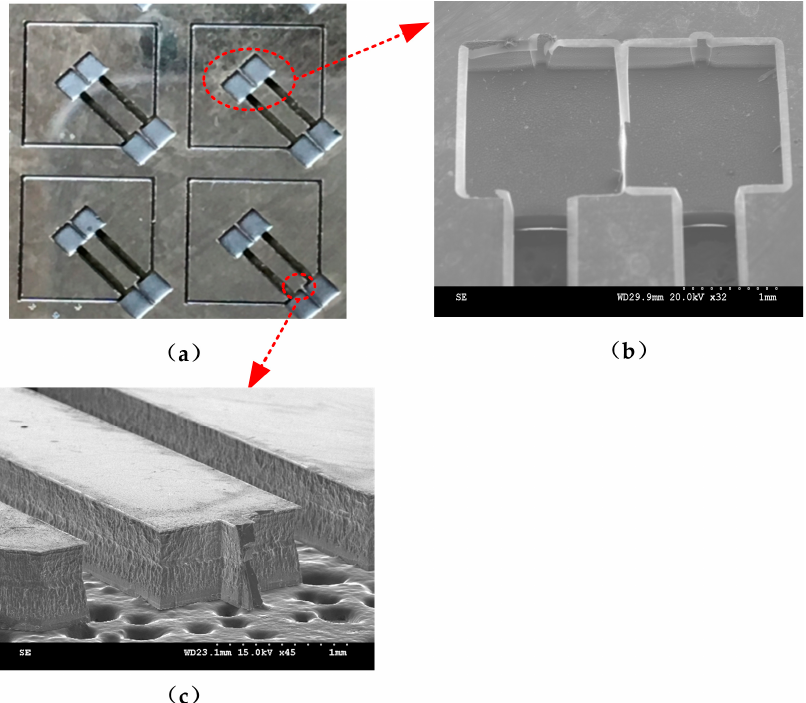
Figure 10. Fabricated silicon substrate and the partial enlarged view: ( a ) fabricated silicon substrate; ( b ) the partial enlarged view of the grooves; and ( c ) cross-section view of the flexure hinge.